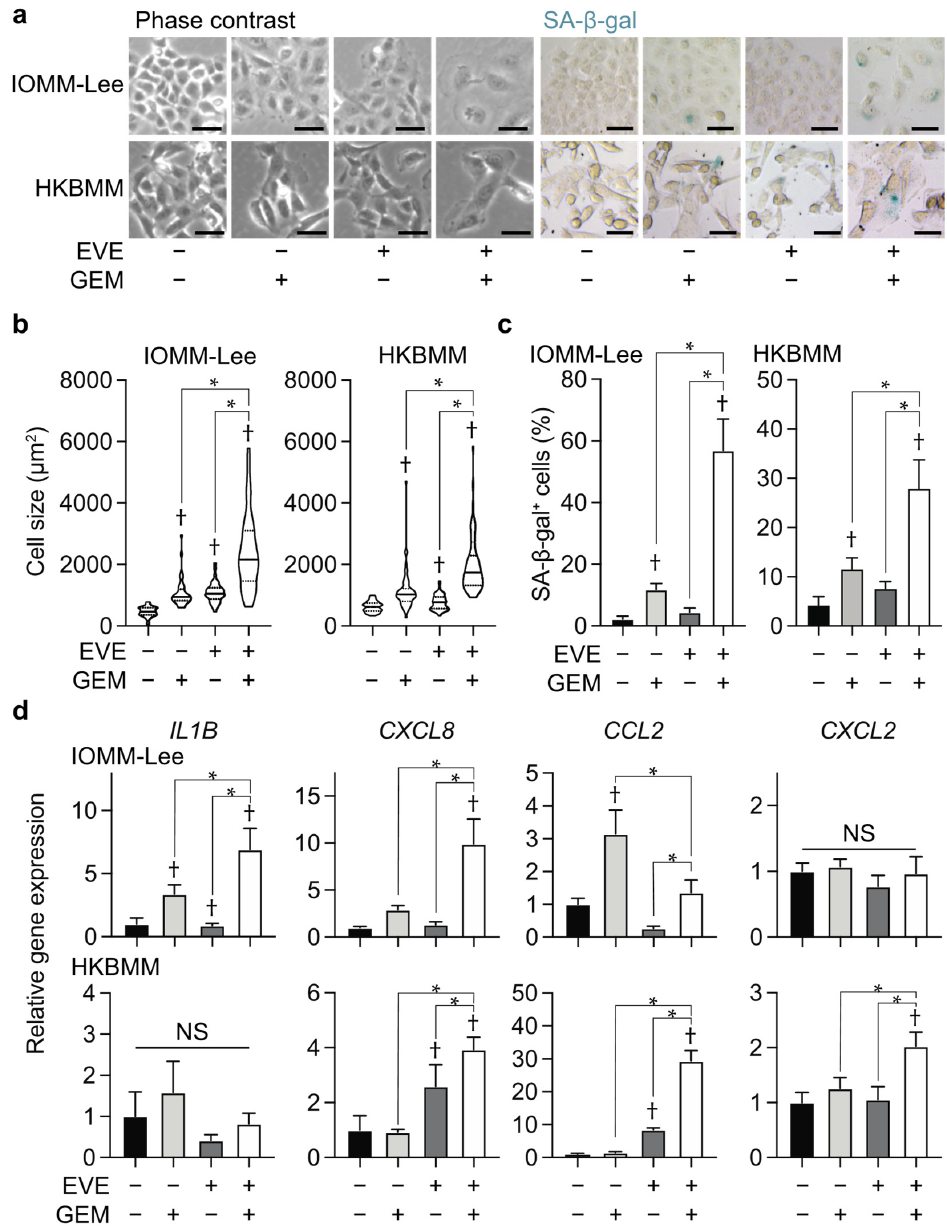
Figure 3. Cellular senescence in malignant meningioma cells treated with everolimus and gemcitabine. IOMM-Lee and HKBMM cells were incubated without or with everolimus (EVE, 5 nM) for 4 days in the absence or presence of gemcitabine (GEM, 3 nM for IOMM-Lee and 2 nM for HKBMM) and subjected to evaluations of cell sizes ( a , b ), SA- β -gal staining ( a , c ), and RT-qPCR in 5 replicates to assess the expression of the indicated genes ( d ). ( a ) Representative phase-contrast images and SA- β -gal staining. Scale bars, 50 µ m. ( b ) Quantification of cell sizes. The size of more than 40 cells per group was measured and shown as violin plots (lines, median; dotted lines, quartile). ( c ) The percentages of SA- β -gal-positive cells were quantified ( n = 4, each group). ( d ) Relative gene expression to untreated cells (EVE − and GEM − ). Similar results were obtained from 2 independent biological replicates. Values are shown as the mean + SD. p -values were calculated by the Kruskal–Wallis test with Dunn’s multiple comparison test ( b ) or by a one-way ANOVA with Tukey’s ( c ) or Sidak’s multiple comparison test ( d ). * p < 0.05. † p < 0.05, vs. the Control (EVE − and GEM − ). NS: p ≥